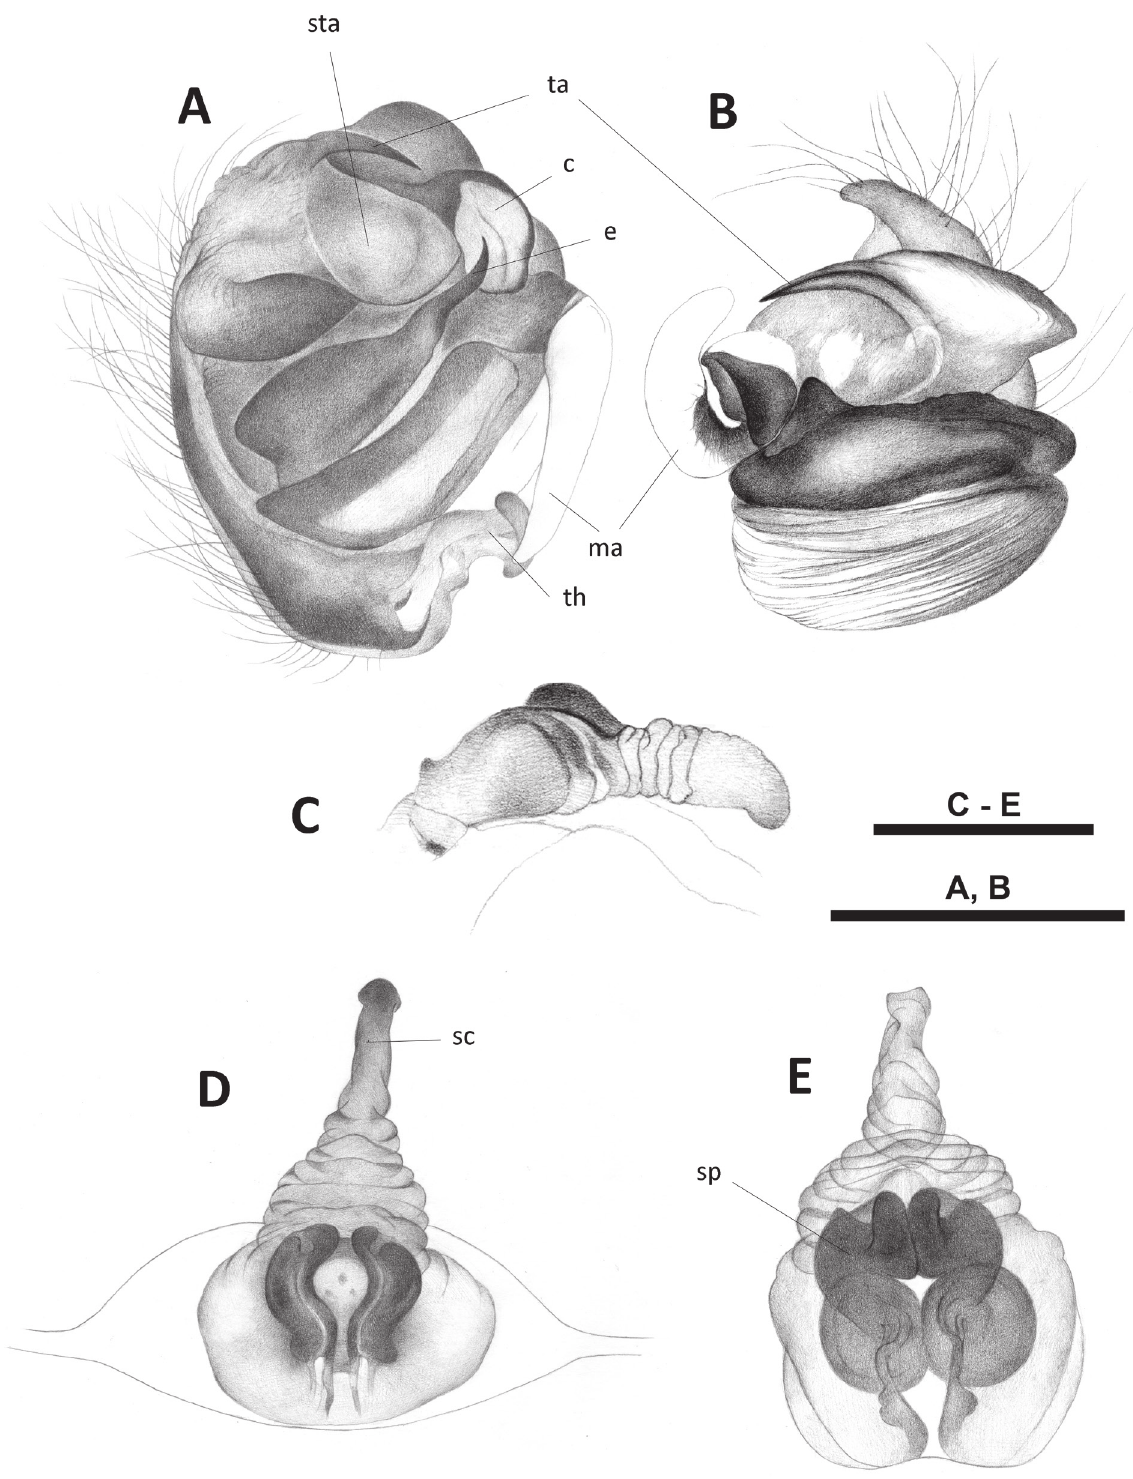
Fig. 1. Eustala occidentalis sp. nov. A . ♂ left palp, ventral view. B . ♂ left palp, apical view. C . ♀ scapus, lateral view. D . ♀ epigyne scapus, ventral view. E . ♀, spermathecae. c = conductor, e = embolus, ma = median apophysis, sc = scapus, sp = spermathecae, sta = subterminal apophysis, ta : terminal apophysis, th = tarsal hook. Scale lines = 0.5